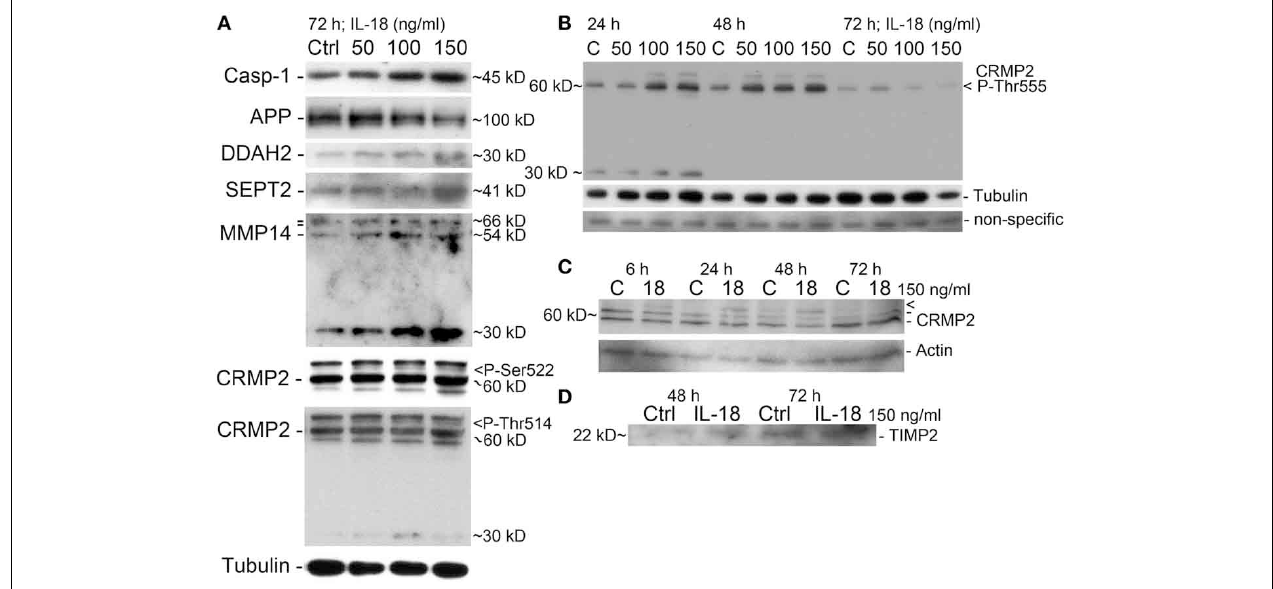
FIGURE 3 | Western immunoblot verification of the selected targets. (A) IL-18 induced our apoptosis marker caspase-1 in a concentration dependent manner, with APP level reduced in 72h treated cells. DDAH2 and SEPT2 levels are increased as well as processed MMP14 (54kD) and precursor MMP14 (above, 66kD, propeptide 64kD). The 30kD form may be some a non-typical cleavage form of MMP14 (antibody detects aa 511–582 at C-terminus). CRMP2 P-Ser522 specific antibody detected a faint concentration dependent band ( > ). CRMP2 P-Thr514 also increase ( > ), with the intensity of CRMP2 different to that of CRMP-2 P-Ser522. Also an additional band about 30kD was detectable. All the results are from the same membrane. (B) CRMP2 also showed increased